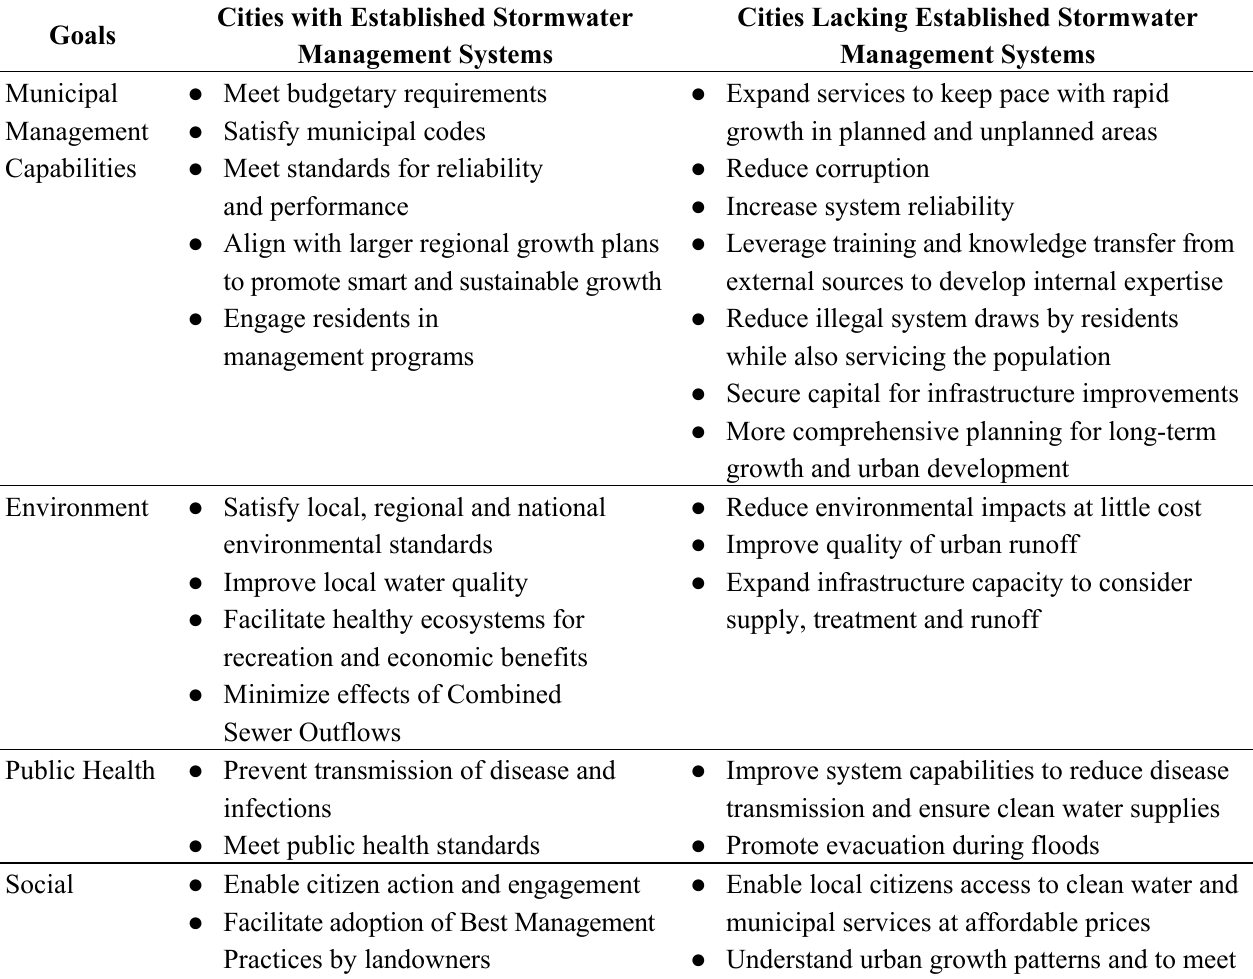
Table 2. Urban stormwater management priorities in